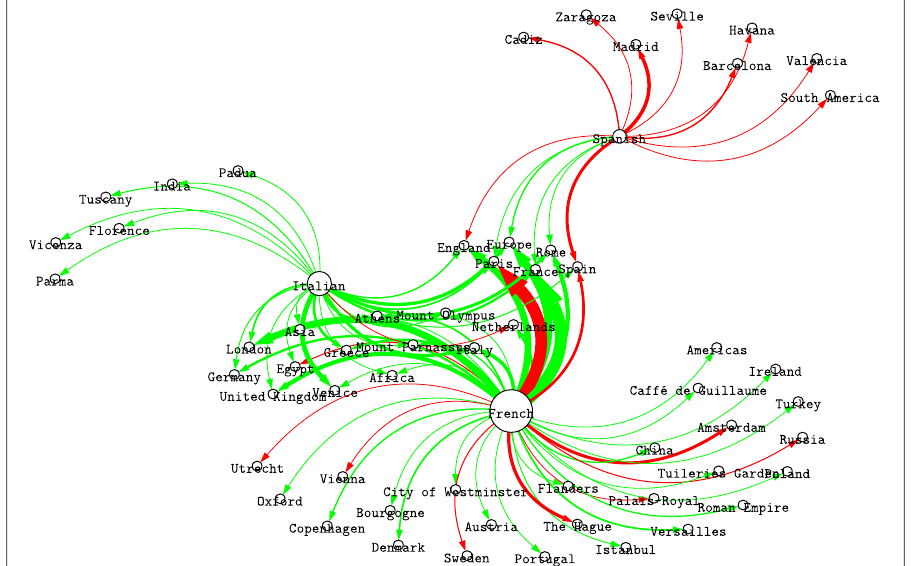
Fig. 6 Sentiment Between Languages and Places. This figure depicts the respective languages in which periodicals were published and the places referenced by them (both represented by nodes). Directed edges indicate that a periodical referenced a place and the color of edges illustrates the mean standardized sentiment of the text passages in which a respective place was referenced. Node sizes represent the degree of languages and edge widths represent the multiplicity of references. Note that we only show edges with a minimum multiplicity of